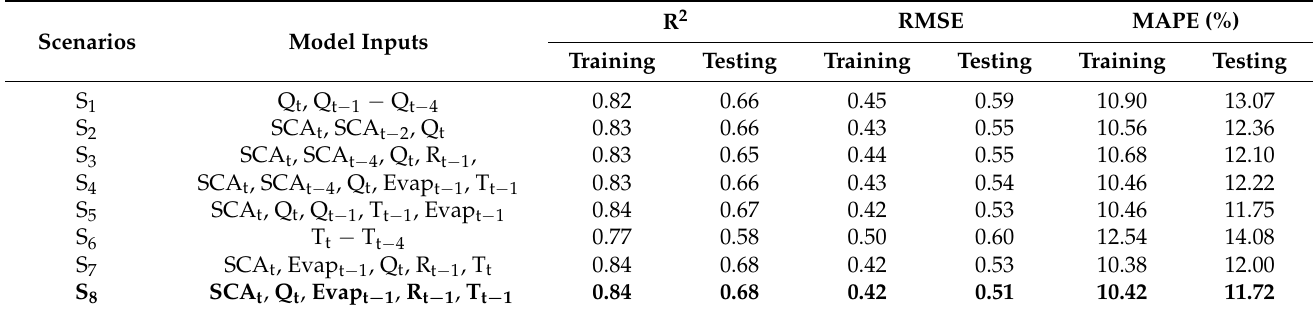
Table 9. Training and testing statistics of the RSM algorithm using various input combinations for the Gilgit River